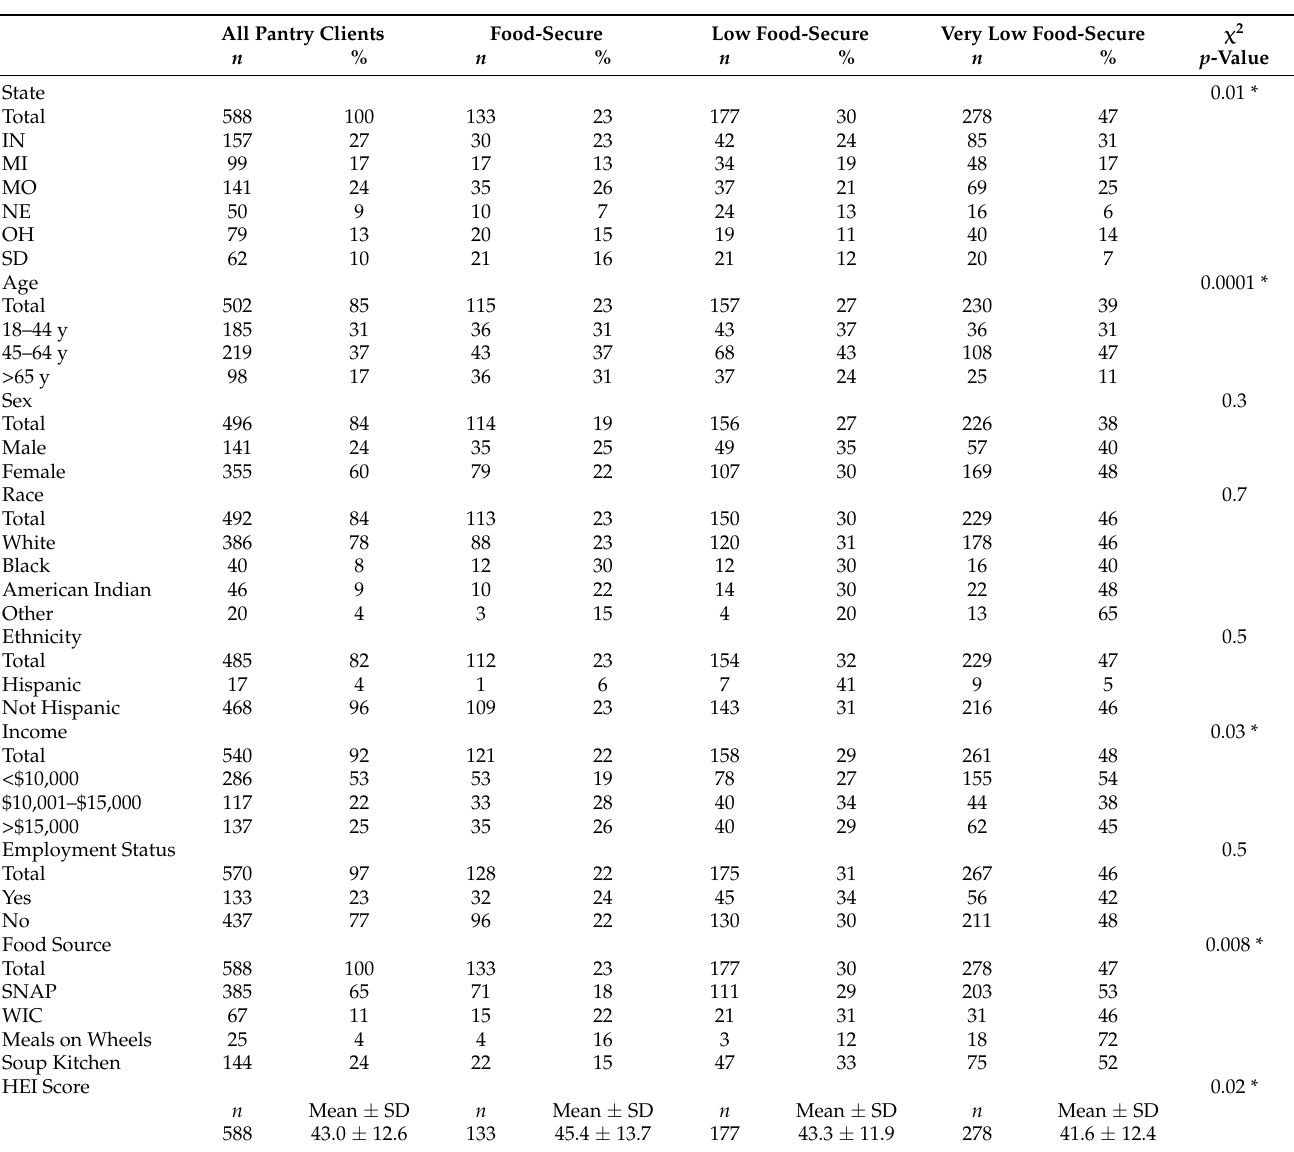
Table 1. Characteristics of a multistate sample of rural, Midwestern, adult emergency food-pantry clients by food-security status ( n =